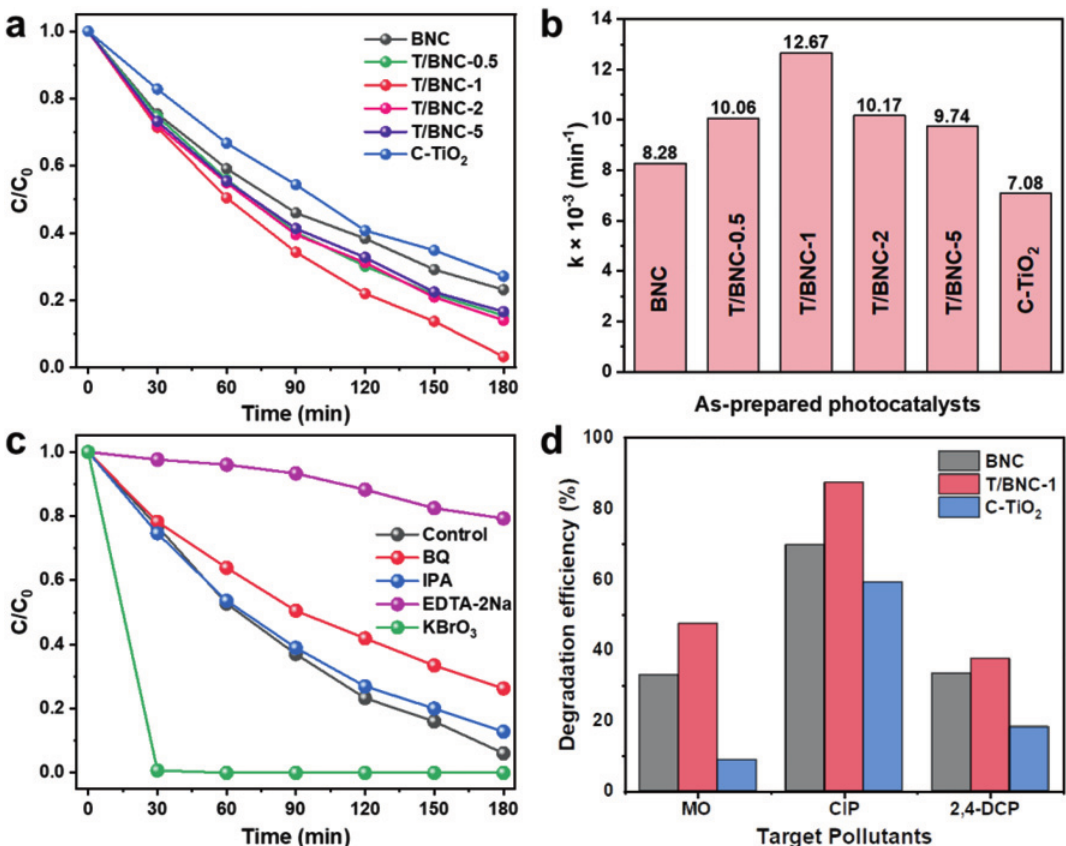
Figure 5: (a) The photocatalytic degradation of RhB by BNC and T/BNC photocatalysts and (b) corresponding kinetic fitting plots. Conditions: [RhB] 0 = 10 mg/L [Cat.] = 1 g/L. (c) Photocatalytic degradation of RhB over T/BNC-1 in presence of different scavengers. Conditions: [RhB] 0 =10mg/L[Cat.]=1g/L.(d)PhotocatalyticdegradationofdifferentorganicpollutantsbyBNCandT/BNC-1.Conditions:[MO] 0 =10mg/L [CIP] 0 = 5 mg/L [2,4-DCP] 0 = 5 mg/L [Cat.] = 1